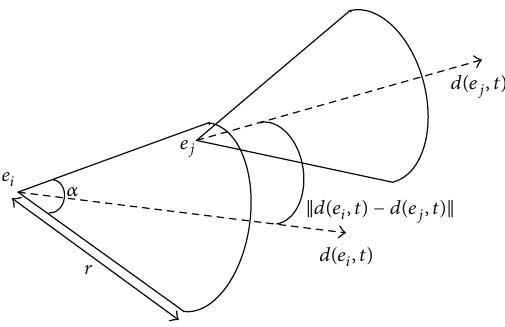
Figure 6: Entity 𝑒 𝑖 follows entity 𝑒 𝑗 at a time-point 𝑡 .